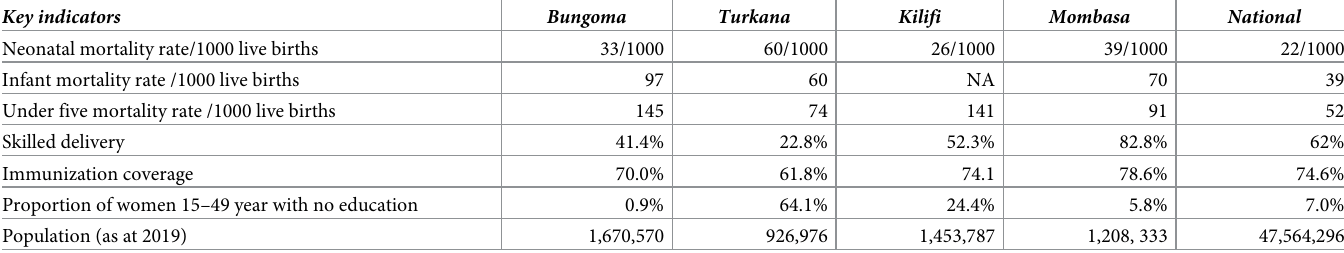
Table 1. Key indicators for the study